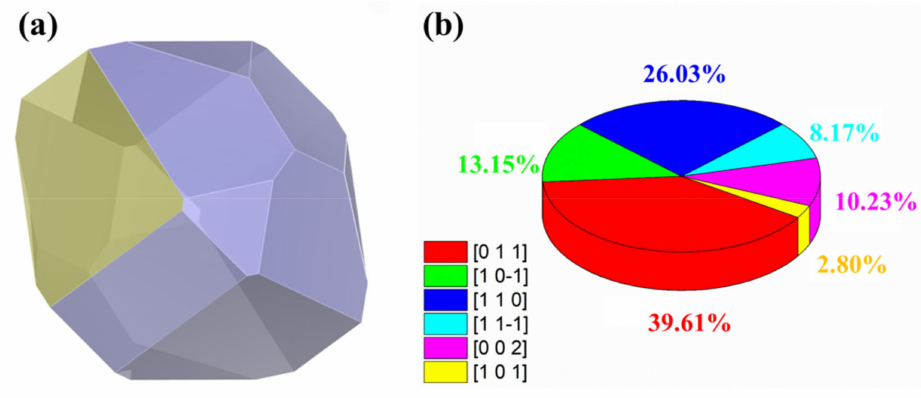
Figure 1. ( a ) Crystal habit of CL-20; ( b ) Proportion of the CL-20 crystal plane